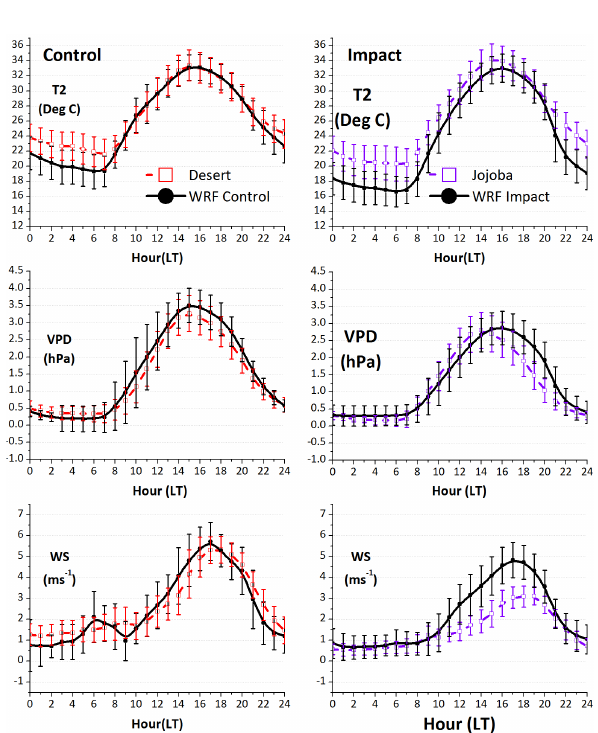
Fig. 8. Validation of WRF Control and Impact with observations for mean summer diurnal cycles of 2m temperature ( T 2), 2m vapour pressure deficit (VPD), wind speeds ( U ). Left hand panels show Control and the right panels, Impact. WRF variables were averaged over a 25 grid cell box centred at the geographical coordinates of the Desert, Jatropha and Jojoba sites. Note: The observations have been extrapolated from the sensor height of 6 to 10m as calculated by